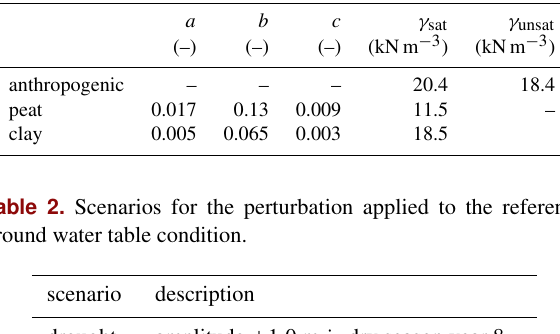
Table 1. Parameter values per lithology.